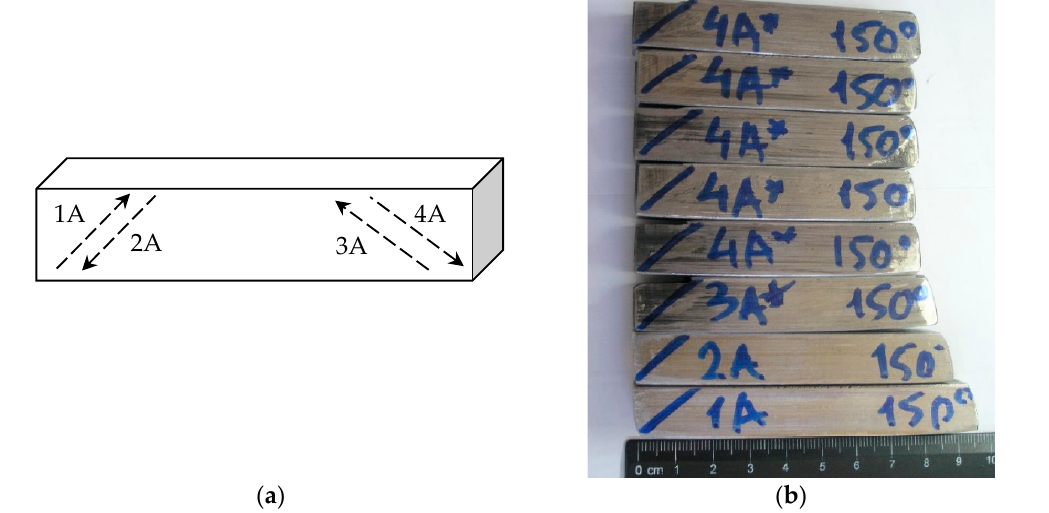
Figure 1. Deformation scheme during ECAP ( a ) and general view of specimens obtained by ECAP at 150 °C ( b ).